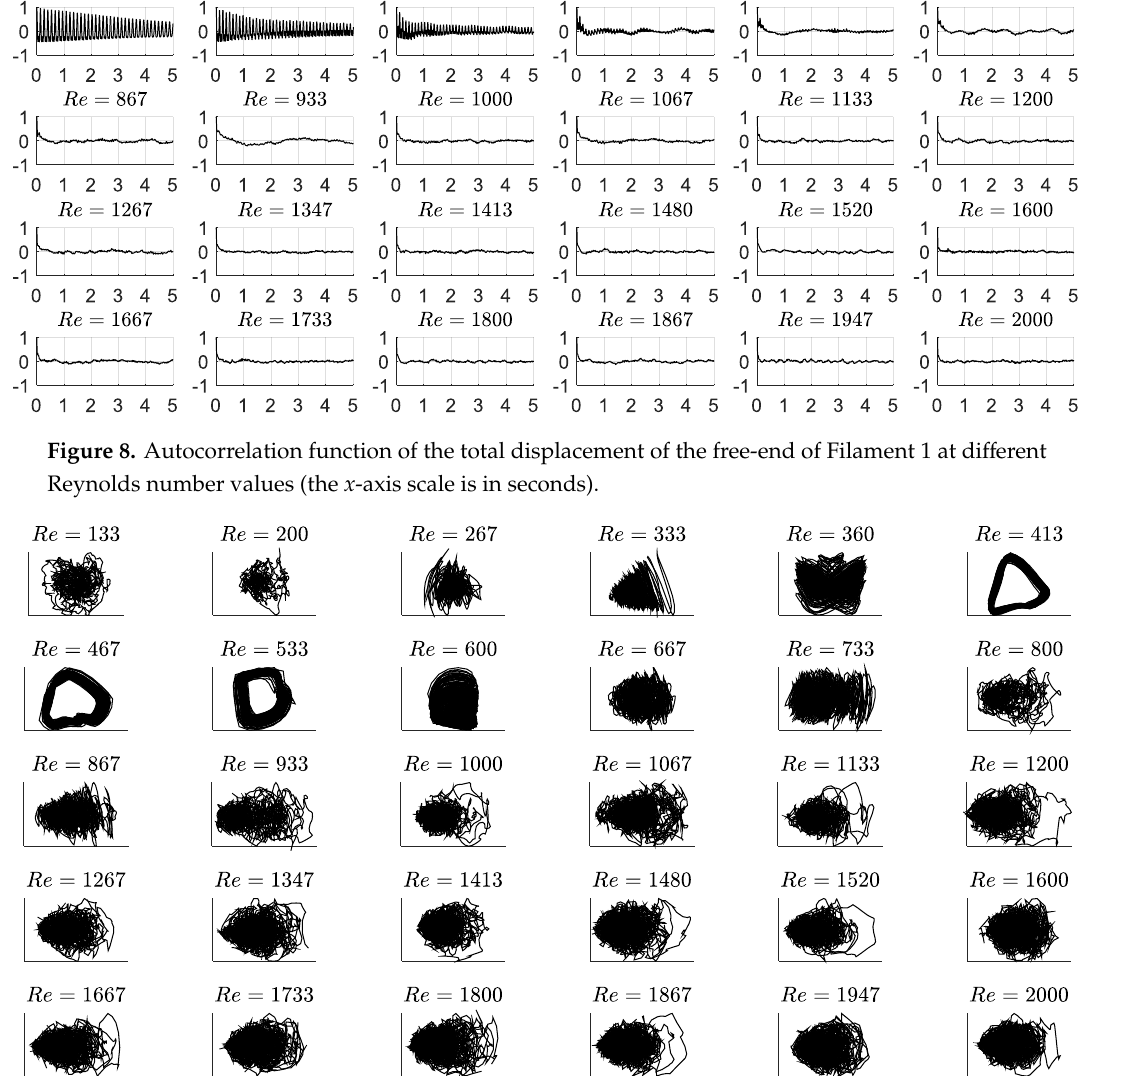
Figure 9. Reconstructed attractor in phase-space for the total displacement of the free-end of Filament 1 at different Reynolds number values.